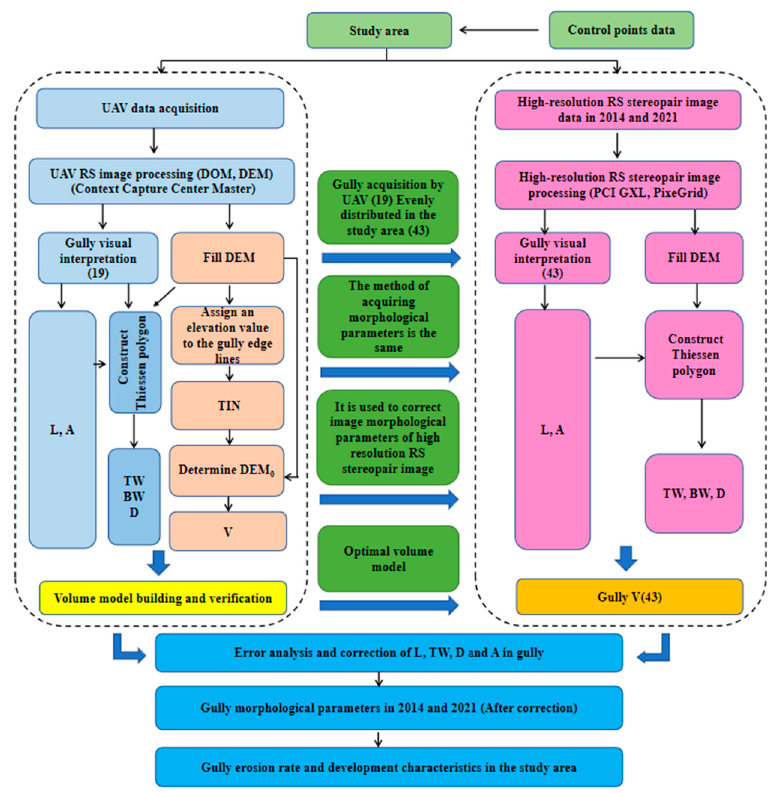
Figure 3. Flowchart of research.